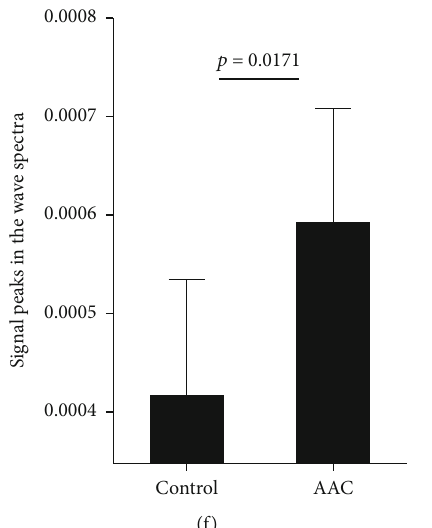
Figure 1: Results of 1 H NMR analysis of rabbit serum. (a) PCA score graph results of 14 samples; (b) PCA score graph results of 13 samples (excluding sample 2); (c) 13 samples (excluding no. 2 sample) PLS-DA score chart results; (d) 13 samples (excluding no. 2 sample) OPLS- DA score chart results; (e) 13 samples (excluding no. 2 sample) PCA load chart; (f) comparison of the peak value of TMAO spectrum between the AAC group and the control